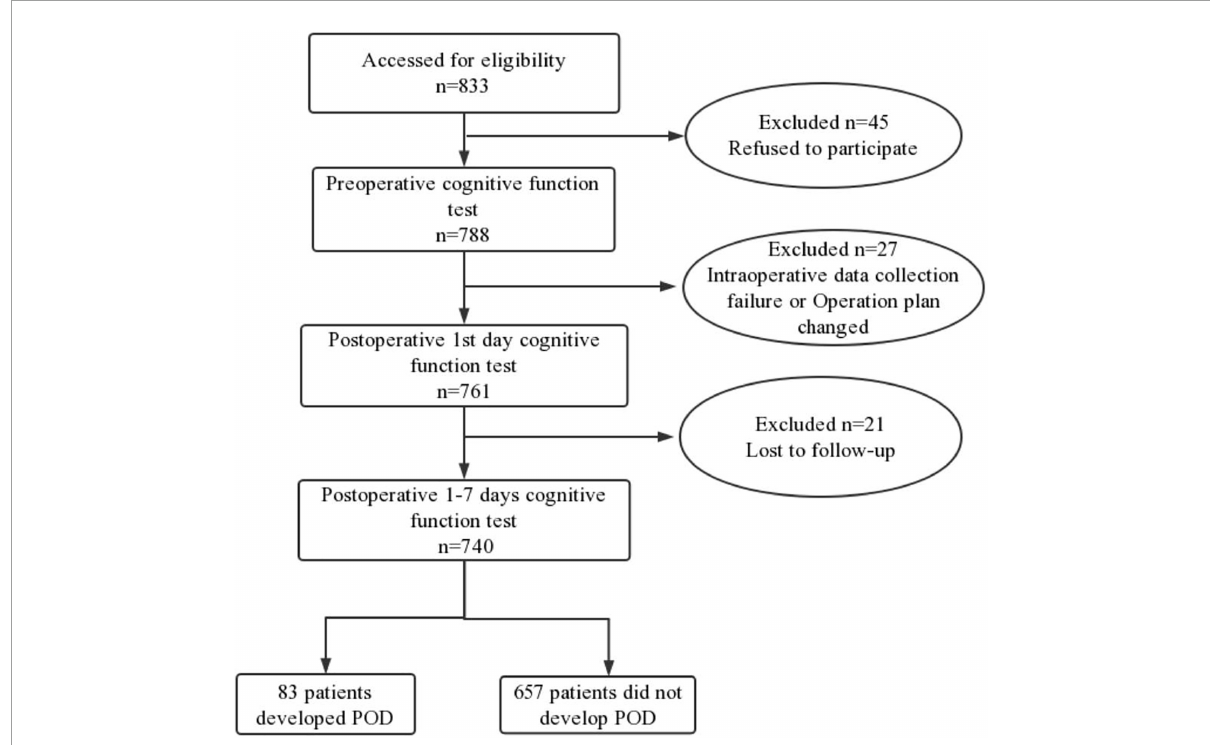
FIGURE1 Flow diagram showed selection of eligible patients and the enrollment process. POD, postoperative